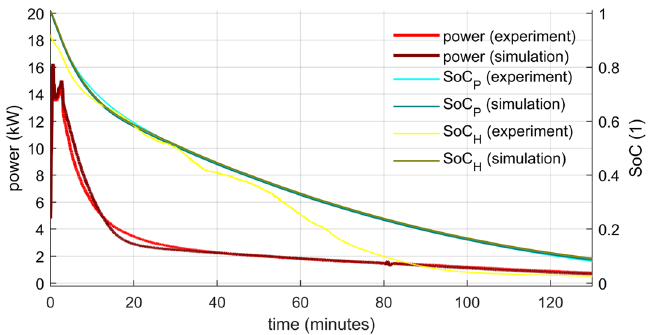
Figure 10. Power and SoC evolution—comparison of the numerical model with the experimental data for lower HTF flow